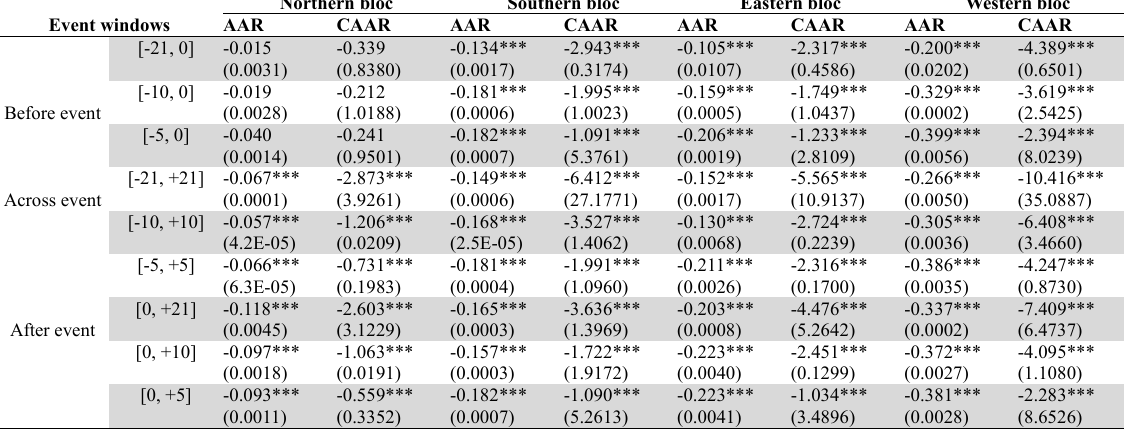
AARs and CAARs around the day (Before, Across, After) of confirmed COVID-19 deaths Northern bloc Southern bloc Eastern bloc Western bloc Event